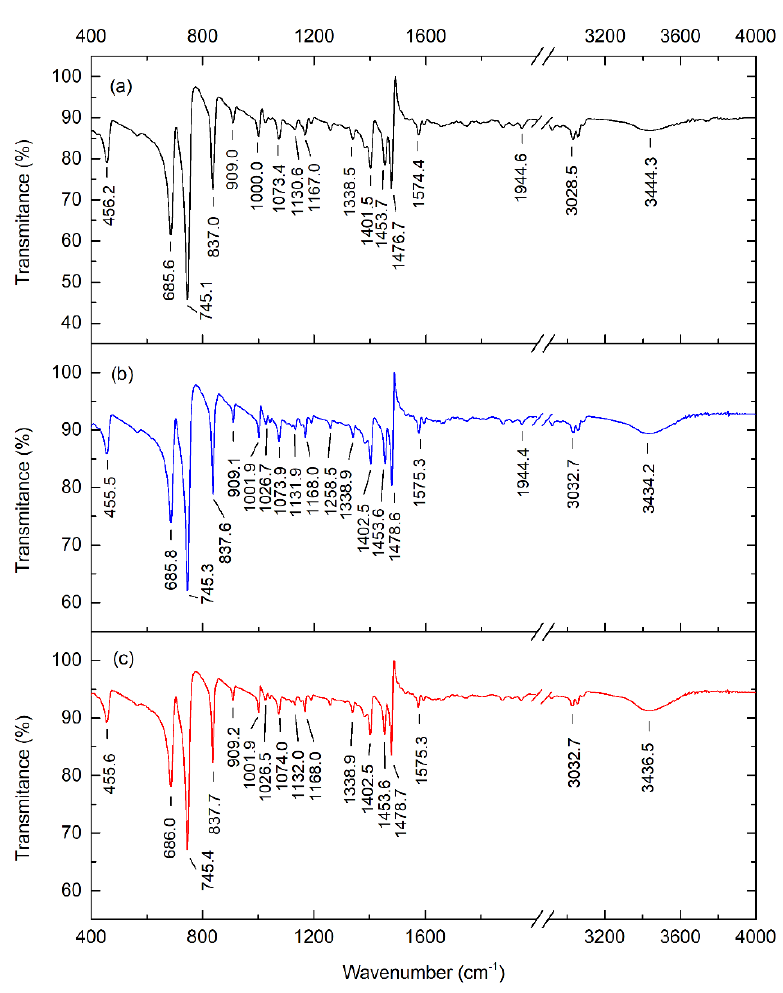
Figure 7. FTIR spectra of ( a ) pure, ( b ) 0.01 wt.%, and ( c ) 0.1 wt.% pentacene−doped p -terphenyl